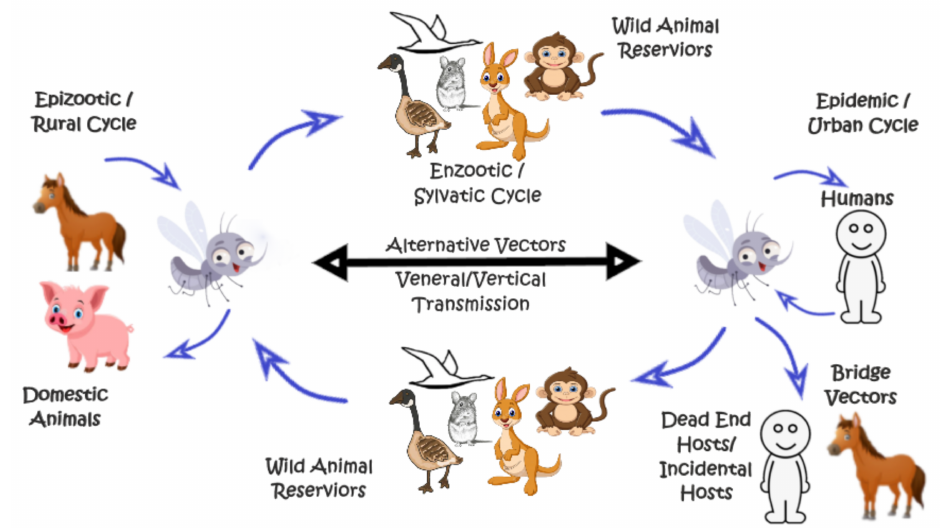
Figure 1. Typical life/transmission cycle of arthropod-borne